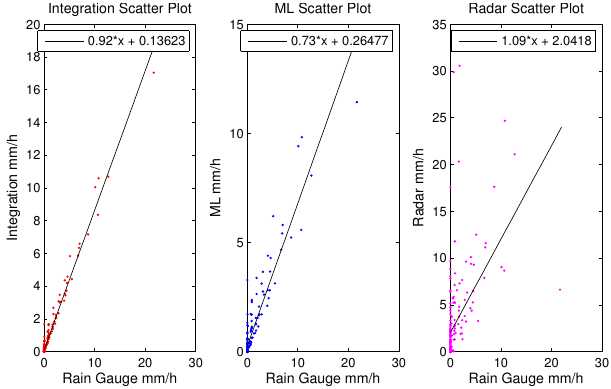
Figure 15. Rain rate scatter plots of the integration (left), ML (mid- Fig. 15. Rain rates scatter plots of the Integration (left), the ML (middle) and the radar (right) with respect to dle) and radar (right) with respect to the rain gauge at the Dorot site theraingaugeinDorotsiteforevent(2). for event